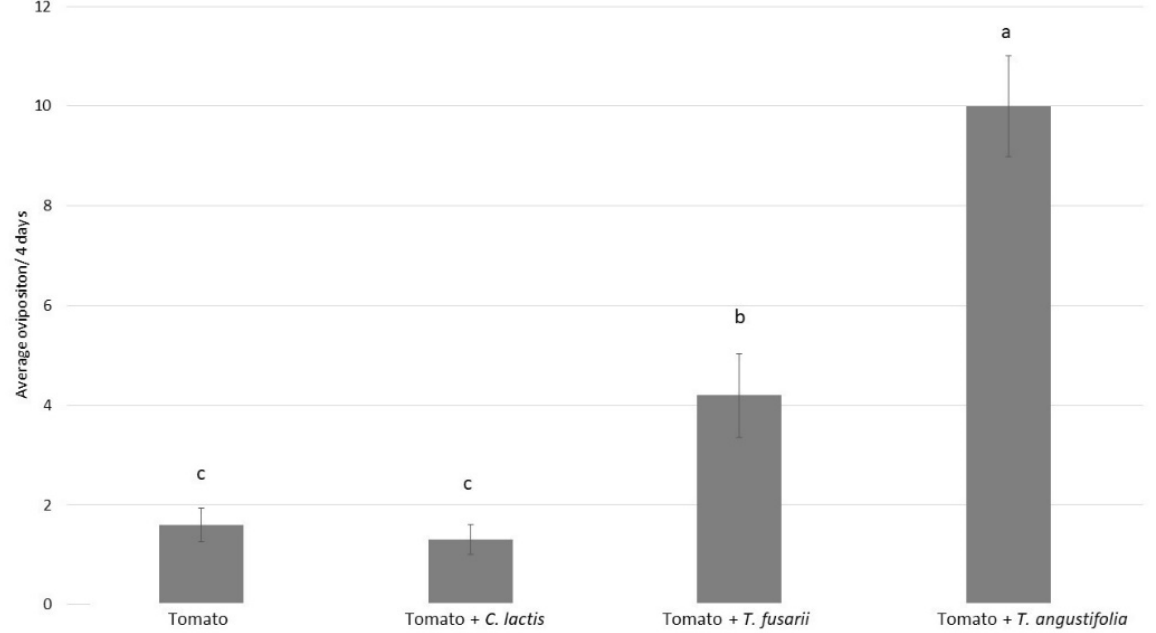
Figure 3. Average total oviposition over four days (mean ± SE) for P. ubiquitus on tomato alone, tomato with C. lactis , tomato with T. fusarii and tomato with T. angustifolia. Different letters above indicate differences among treatments.